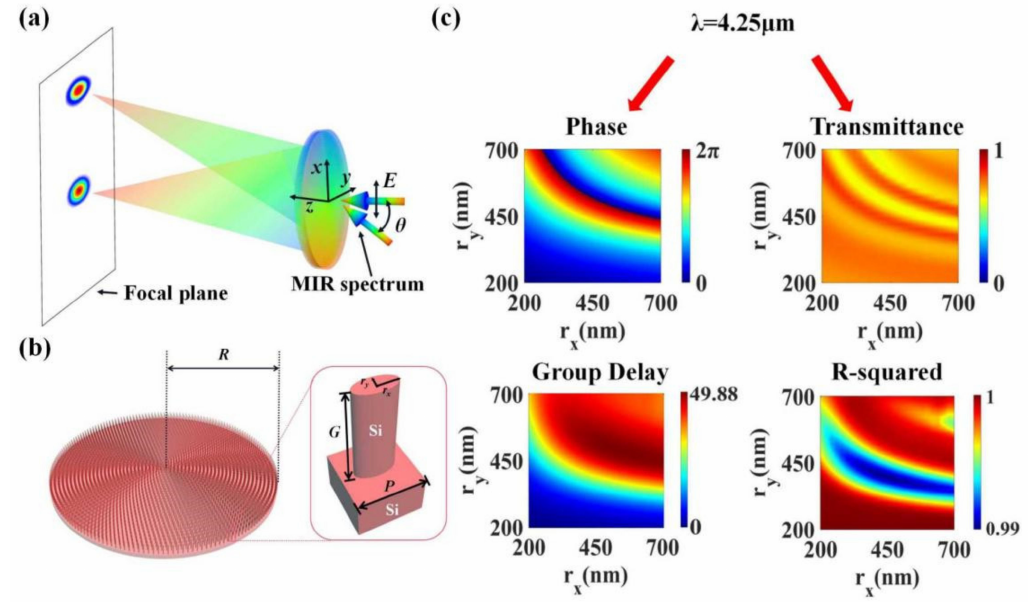
Figure 2. ( a ) Schematic illustration of a wide-FOV and broadband achromatic focusing metalens. The mid-infrared broadband (3.7–5 µ m) x -polarized light is incident on the metalens from the substrate. The transmitted light is focused achromatically on the focal plane. When the inclination angle θ of the incident light varies within ± 30 ◦ , the aberration-corrected metalens can still focus the beam on this focal plane. ( b ) Top view of the metalens and a magnified view of a unit cell on the metalens. The radius of the metalens is R = 50.5 µ m. The unit cell is made of all monocrystalline silicon. The lattice period is set as p = 1650 nm. The height of the elliptical nanorod is G = 4.5 µ m, and the long axis r x and the short axis r y are two variable structural parameters. ( c ) Top left image: Phase spectrum at the center frequency (corresponding wavelength is 4.25 µ m) in the nanorods database. Top right image: Transmittance spectrum at the center frequency in the nanorods database. Bottom left image: GD values of nanorods with different sizes obtained by fitting. Bottom right image: R -squared value corresponding to each GD